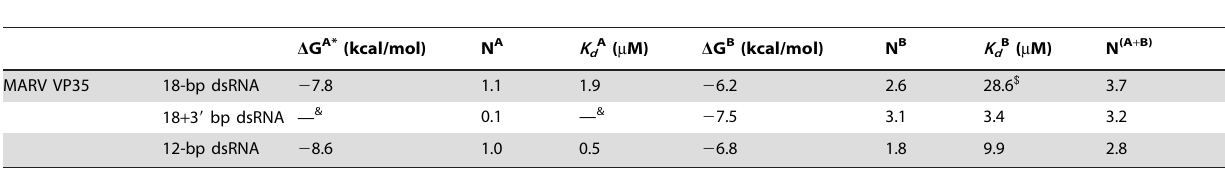
Table 4. Thermodynamic parameters of binding determined by isothermal titration calorimetry (ITC) for dsRNA-binding domains of MARV VP35 with different dsRNA molecules.